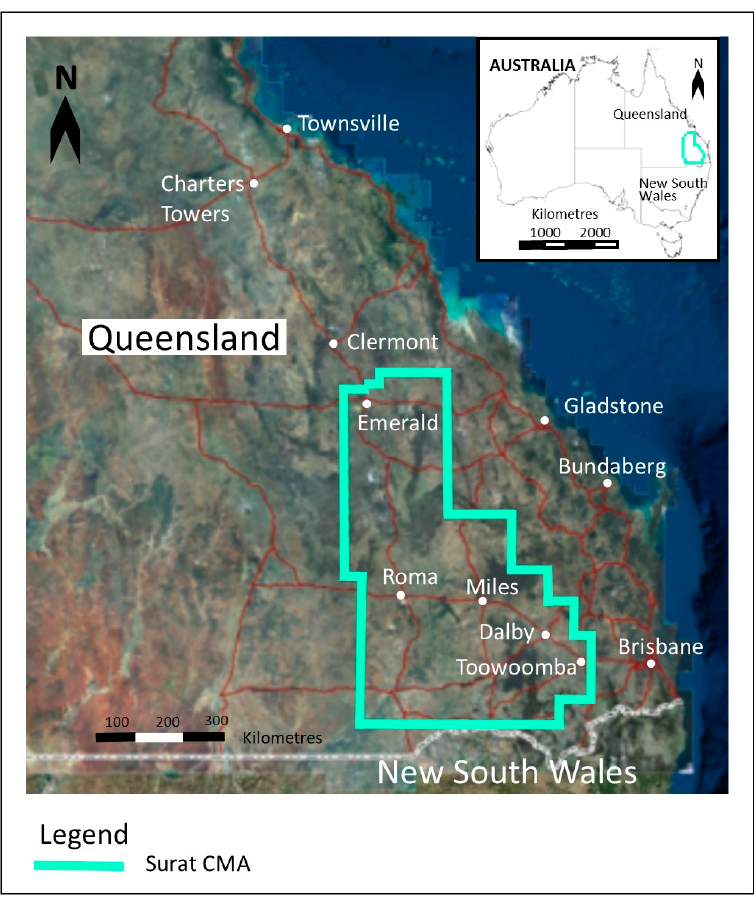
Figure 1. Surat Cumulative Management Area, Queensland, Australia.